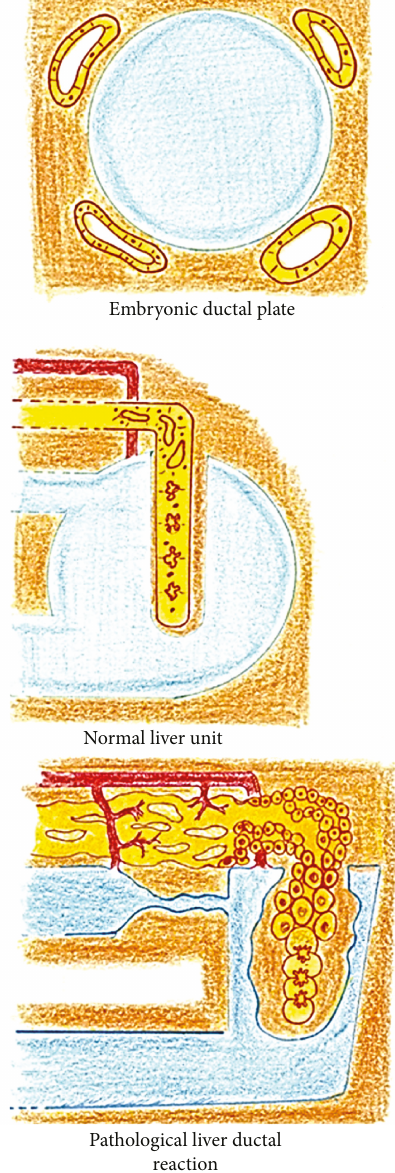
Figure 2: In the liver, the ductular reactions (bottom) could adopt ductal plate con fi gurations (superior). In addition, the normal hepatic structure, represented by a functional hepatic unit (middle), is also based on the ductal plate con fi